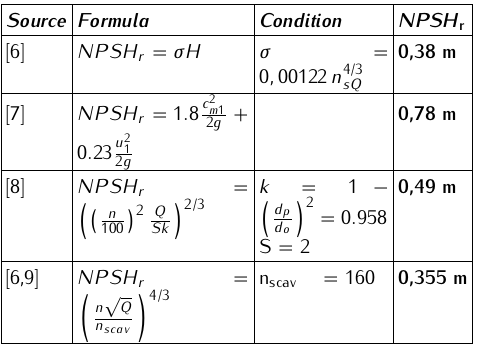
Table 3. NPSH r for E3 impeller, according to analytical formulas.